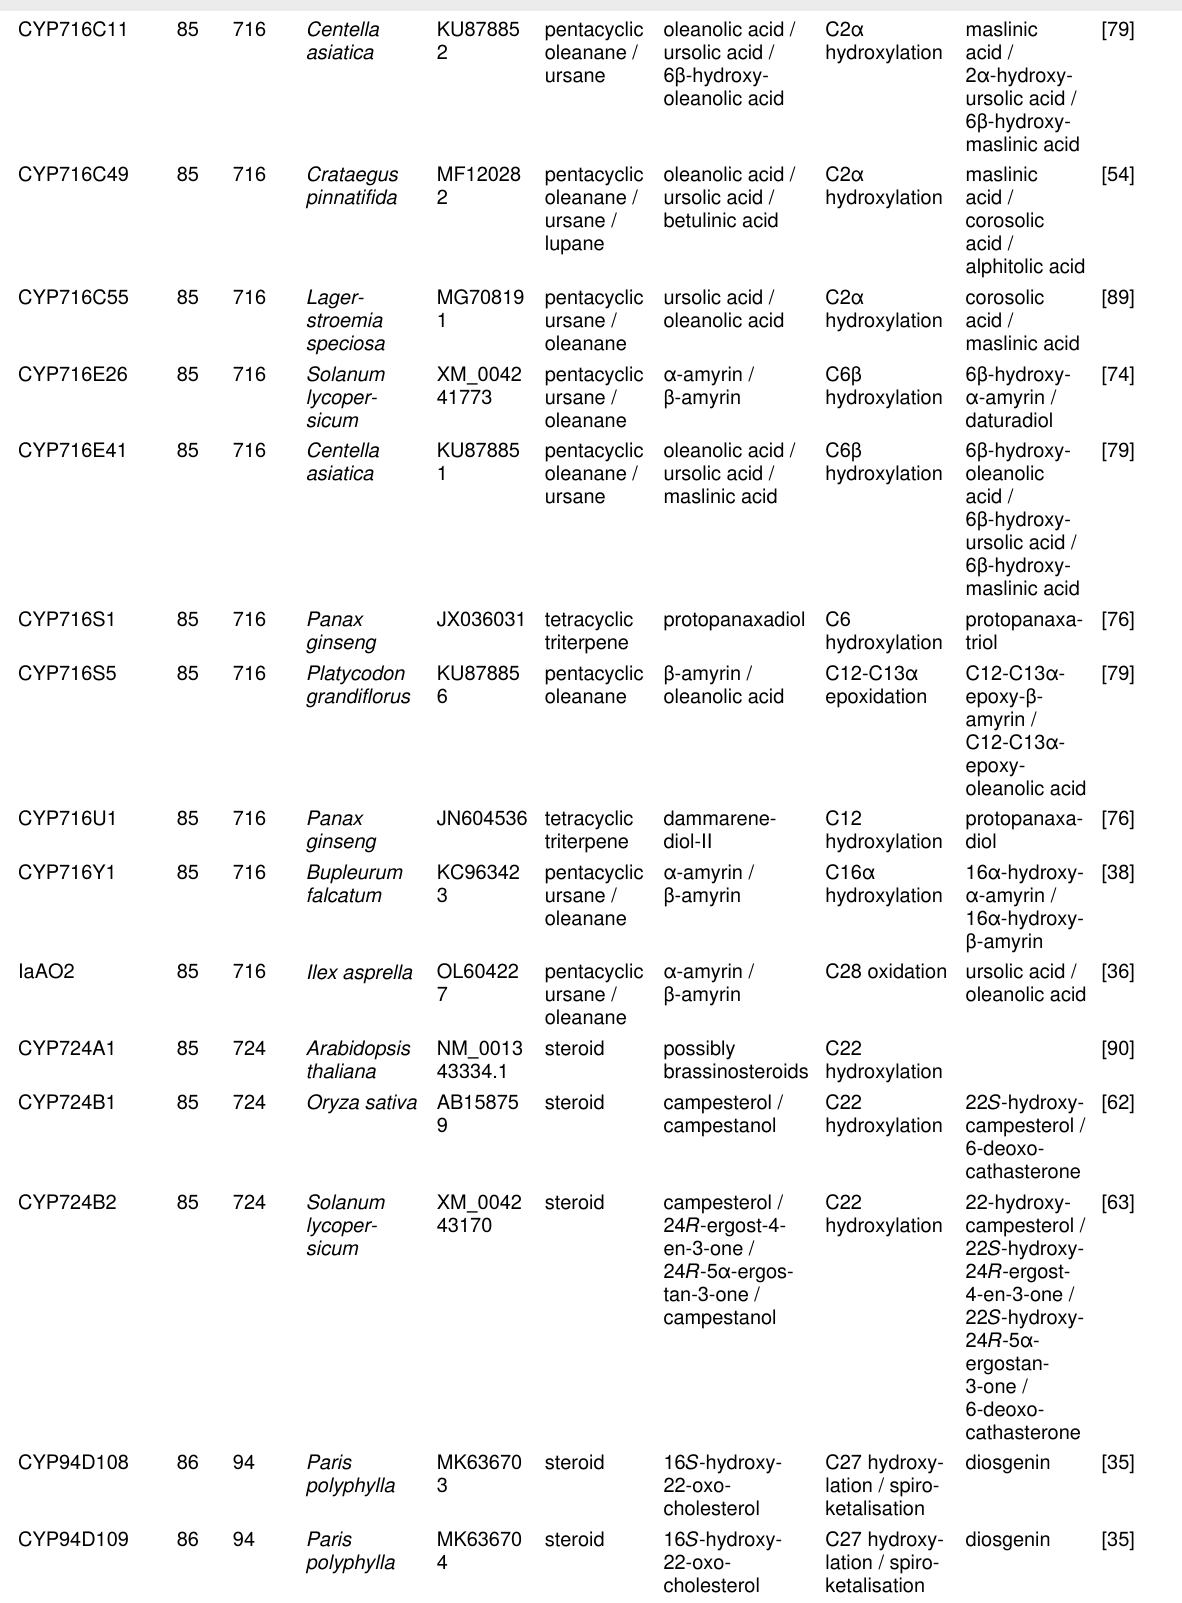
Table 1: List of characterised plant cytochrome P450 monooxygenases (CYPs) modifying triterpenoids or steroids. (continued)